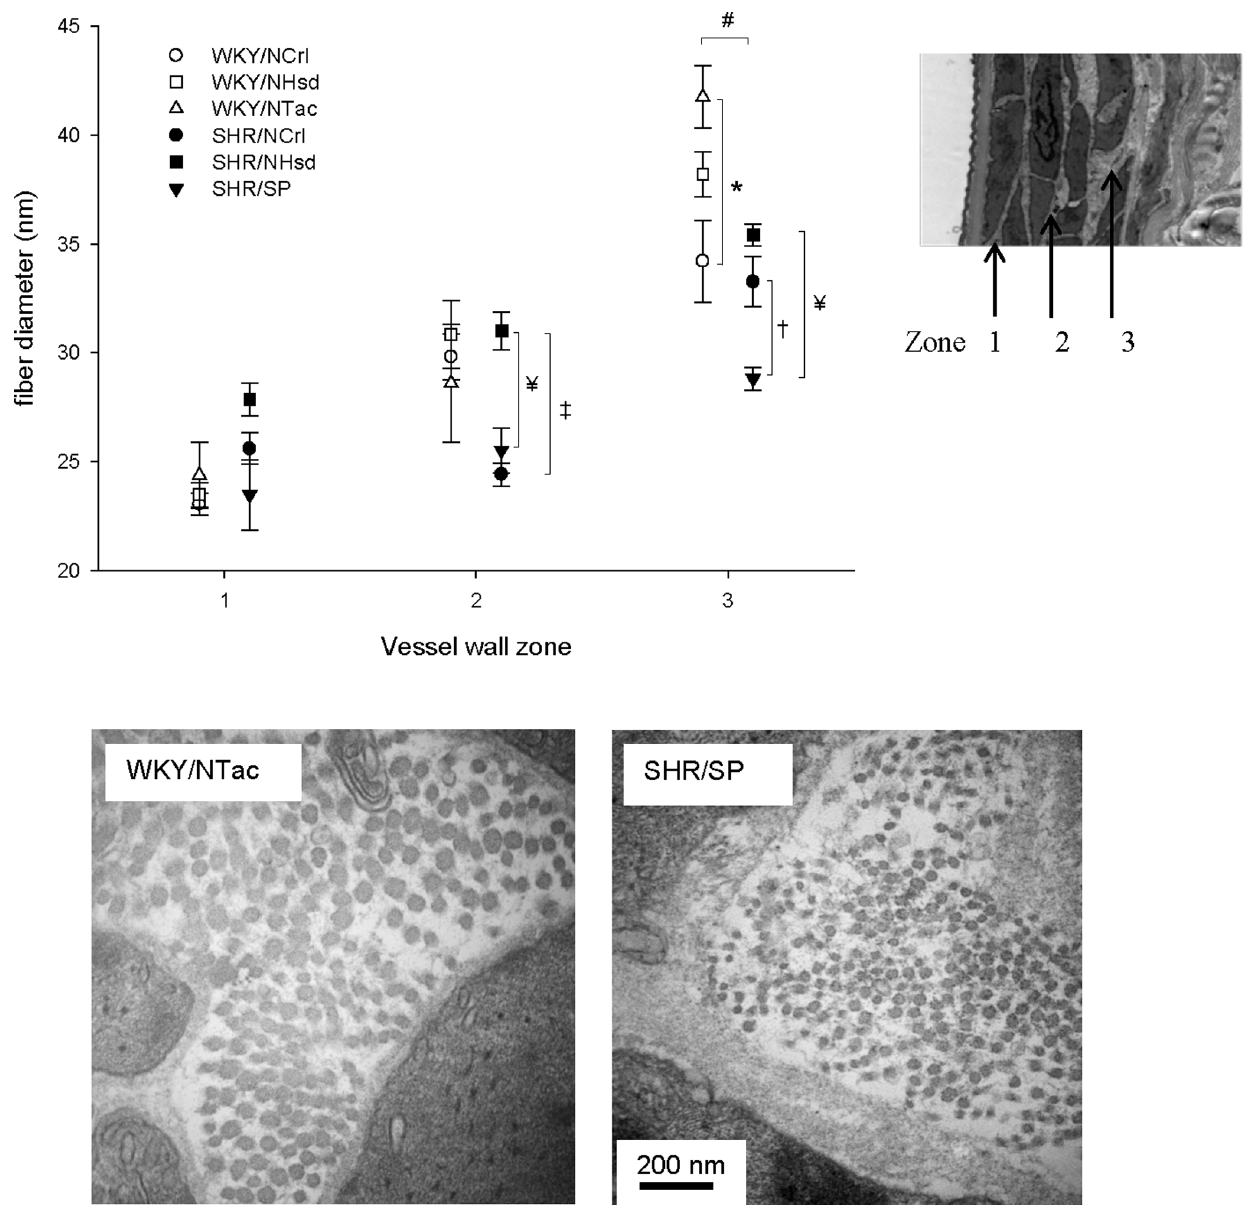
SHR/SP. Examples of collagen fibers in zone 3 in the WKY/NTac and the SHR/SP are shown in panel B. Data represent N=3 in each group, at 5 months of age. On average, more than 1000 fibers were measured in each vessel. * indicates P , 0.05 for WKY/NCrl vs. WKY/NTac, { SHR/NCrl vs. SHR/SP, ` SHR/NCrl vs. SHR/NHsd, ¥ SHR/NHsd vs. SHR/SP, # WKY vs. SHR.